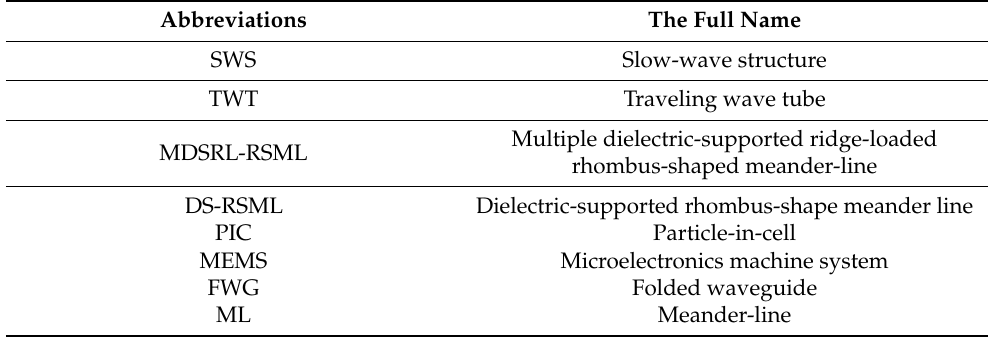
Table 1. Glossary of abbreviations.